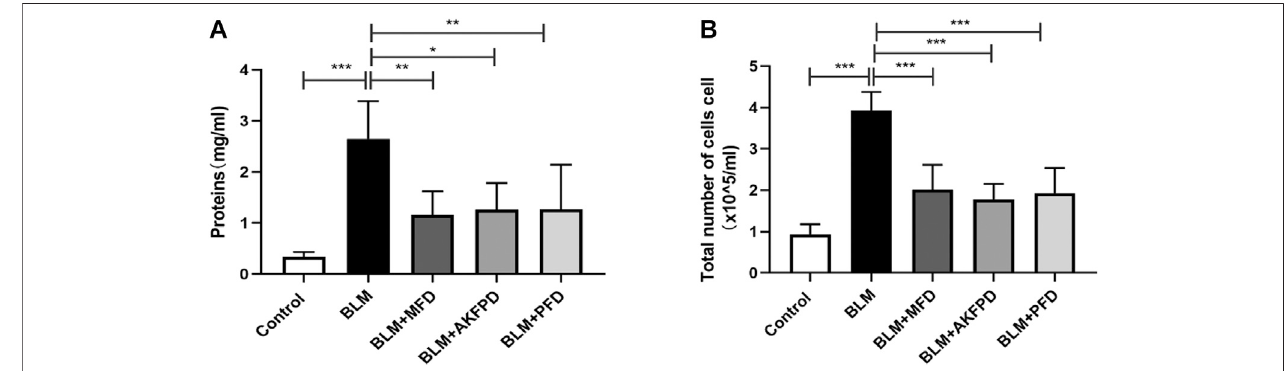
FIGURE3| Mefunidonedecreasedproteinconcentrationandcellcountinbronchoalveolarlavage fl uids (A – B) :Totalproteinconcentrations (A) andcellcounts (B) in bronchoalveolar lavage fl uids of mice. All data were presented as mean ± SD. ANOVA was used for comparison in (A – B) .* p < 0.05; ** p < 0.01; *** p < 0.001.